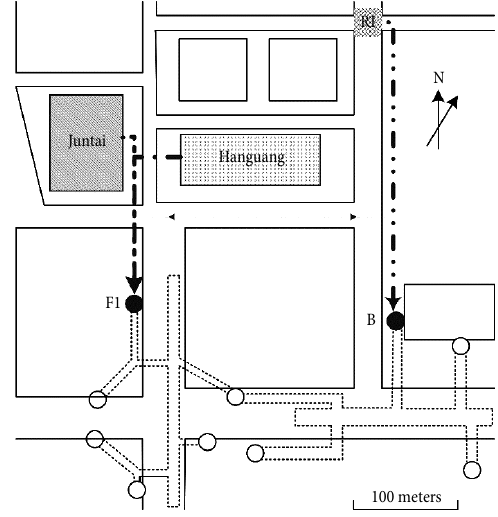
Fig. 3. Locations of F1, B, Juntai, Hanguang and RI and the passenger